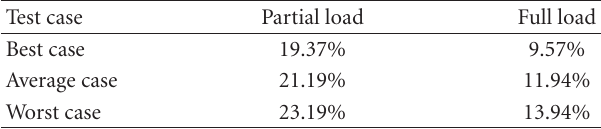
Table 4: Monte-Carlo analysis for the fuzzy controller: NSSE%